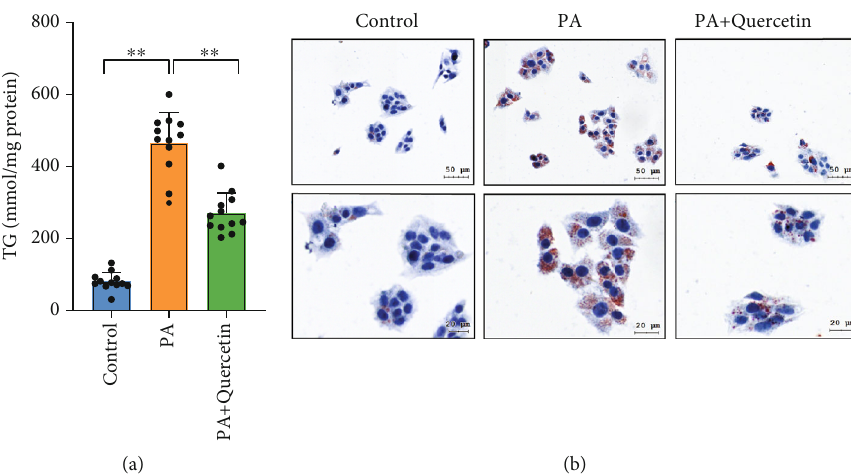
Figure 7: Anti-NAFLD e ff ect of quercetin in PA-induced HepG2 cells. (a) TG contents in HepG2 cells treated with DMSO or 25 μ M quercetin in response to BSA or 0.4mM PA stimulation for 24 h ( n = 12 ). Data are presented as the mean ± S : E : M . ∗ P < 0 : 05 and ∗∗ P < 0 : 01 . (b) Oil red O staining showing that PA induced lipid accumulation, which was suppressed after quercetin treatment for 24h in HepG2 cells ( n = 4